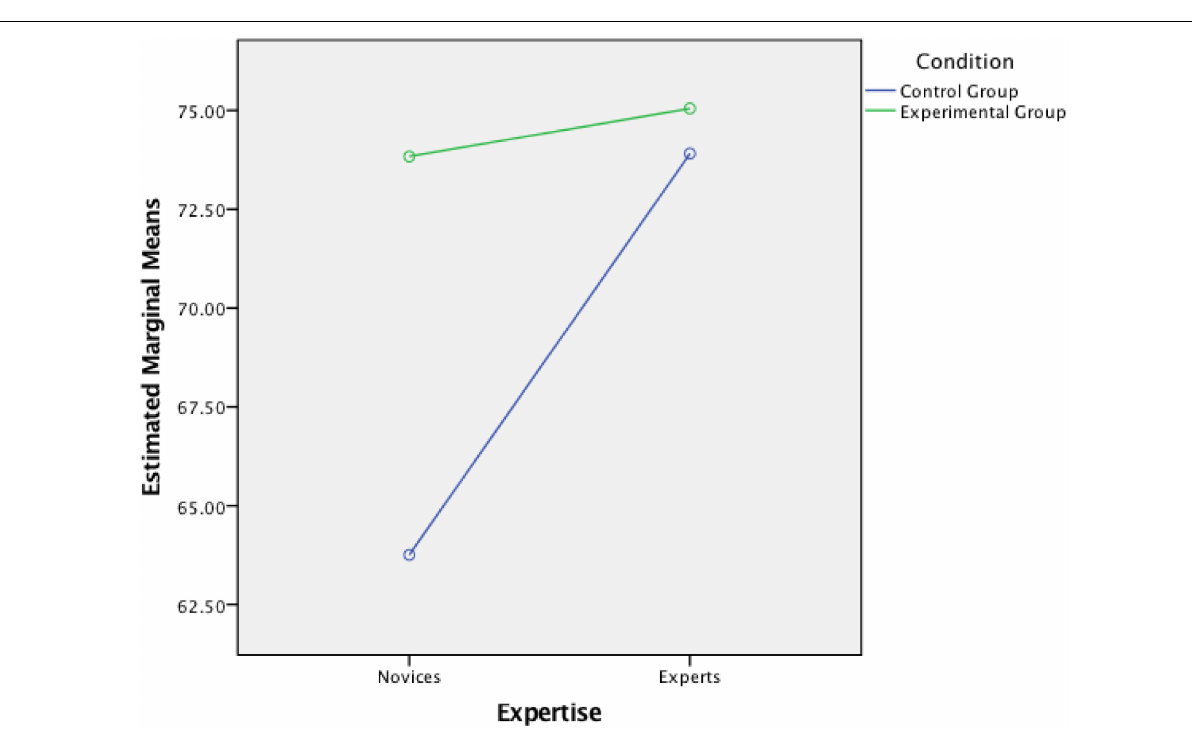
FIGURE 7 | The interaction effect between expertise and condition on the second design